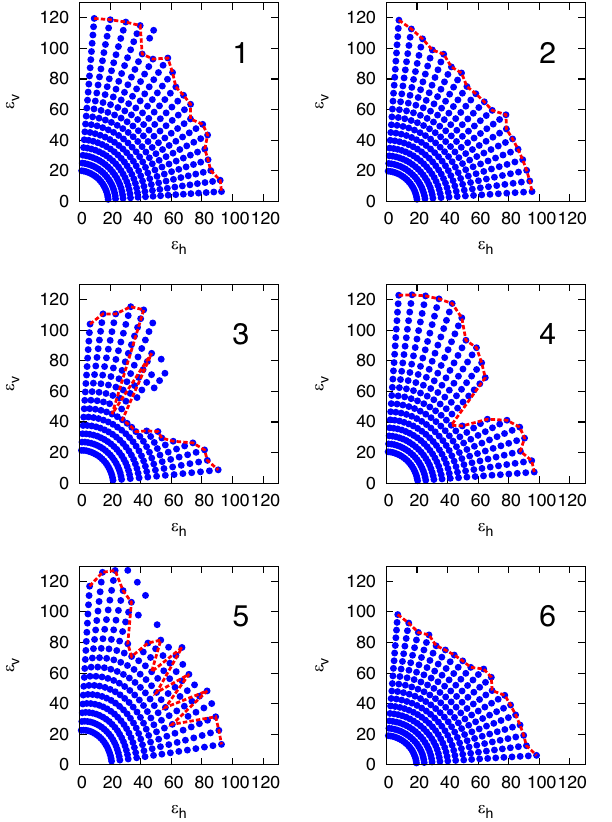
FIG. 10. Initial emittances plotted in units of π mm mrad for particle with dp=p ¼ 2 × 10 − 3